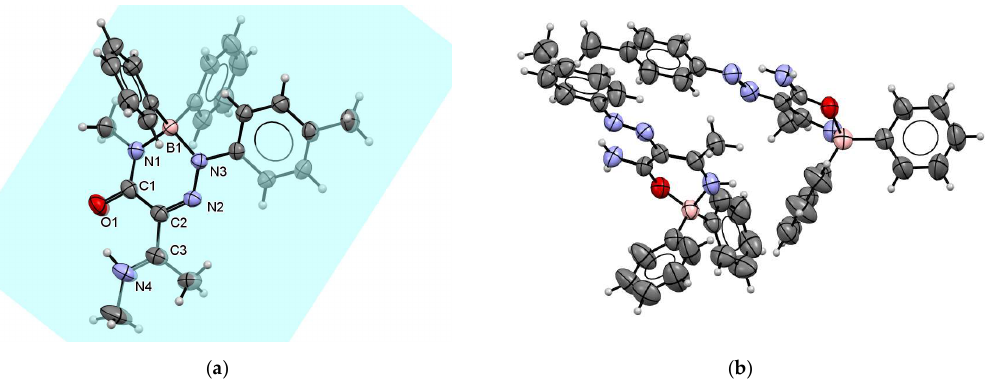
Figure 12. ORTEP diagram of the triazaborinone 5g crystal ( a ); and ORTEP diagram of the oxazaborine 6a crystal ( b ).